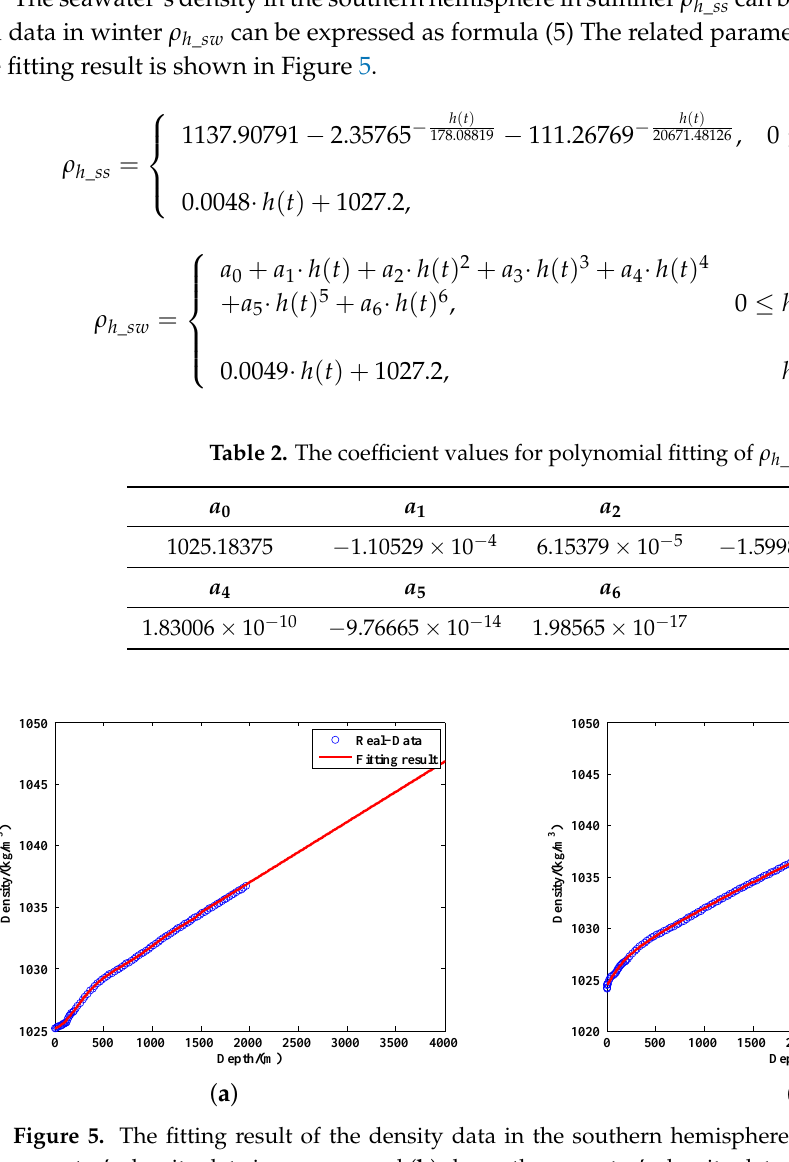
Figure 5. The fitting result of the density data in the southern hemisphere. Panel ( a ) shows the seawater’s density data in summer and ( b ) shows the seawater’s density data in